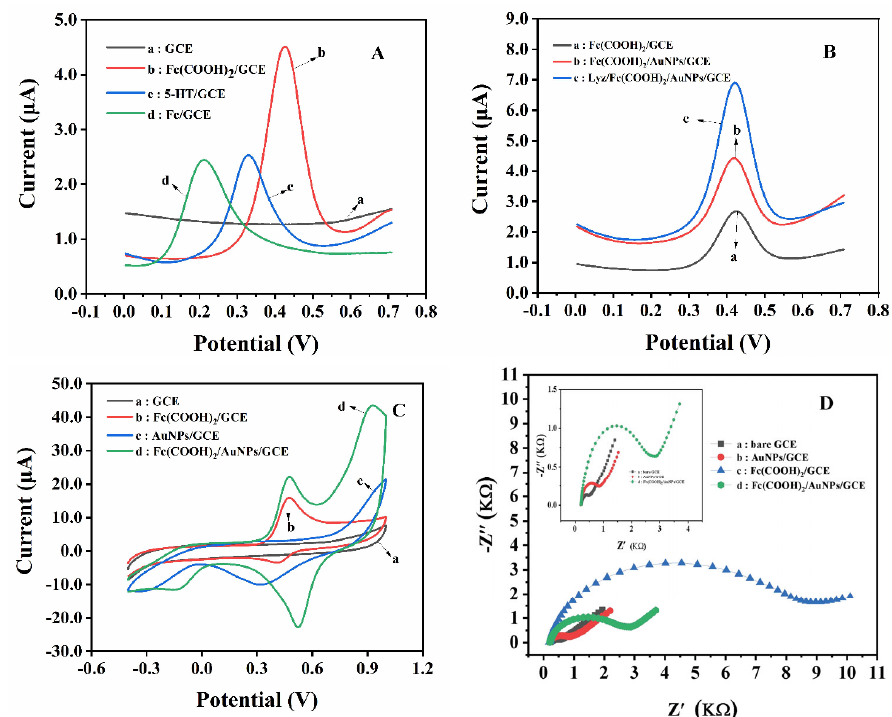
Figure 1. ( A ) DPV of the different NPs modified on GCE in trisodium citrate solution (a. GCE, b. Fc(COOH) 2 /GCE, c. 5 − HT/GCE, and d. Fc/GCE); ( B ) DPV of different sensors were detected in trisodium citrate solution (a. Fc(COOH) 2 /GCE and b. Fc(COOH) 2 /AuNPs/GCE), Fc(COOH) 2 / AuNPs/GCE was used in trisodium citrate solution of 0.5 mmol · L − 1 Lyz (c. lyz/Fc(COOH) 2 / AuNPs/GCE); ( C ) CV of different sensors in trisodium citrate solution (a. GCE, b. Fc(COOH) 2 /GCE, c. AuNPs/GCE, and d. Fc(COOH) 2 /AuNPs/GCE; ( D ) EIS curves of different modified electrodes (a. bare GCE, b. AuNPs/GCE, c. Fc(COOH) 2 /GCE, and d. Fc(COOH) 2 /AuNPs/GCE), insert: EIS and supporting electrolyte solution is 5.0 mmol · L − 1 [Fe(CN) 6 ] 3 − /4 − containing 0.1 mol · L − 1